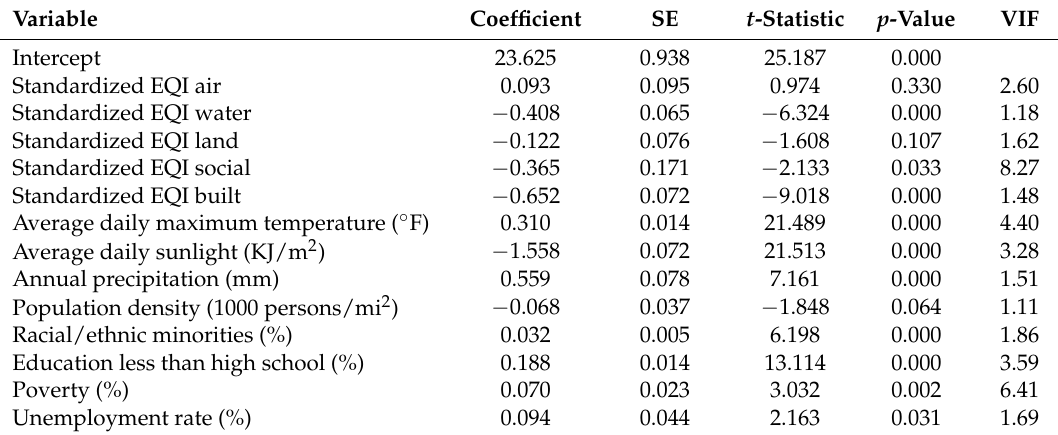
Table 3. Estimated effects of environmental quality index (EQI) subscales (i.e., air, water, land, built, and social environment) on county-level prevalence of physical inactivity using